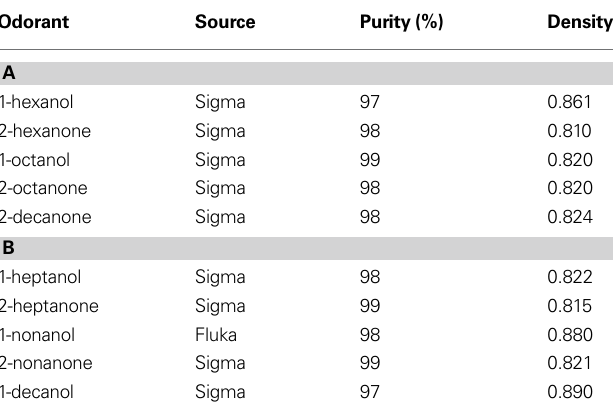
Table 1 | Primary (A) and secondary (B) panel of odorants used in experiments. Listing of odorant, source, purity and